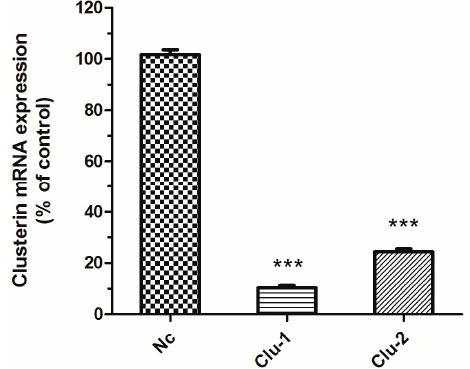
Figure 2. Knockdown of Clu gene expression in SH-SY5Y cells. The cells were infected with lentivirus packaged from the plasmids pLKO–shRNAClu1 (Clu-1), pLKO–shRNAClu2 (Clu-2) and pLKO-shRNANc (Nc), respectively. The mRNA expression level was detected by the real-time PCR assay. Cells infected with the lentivirus containing the